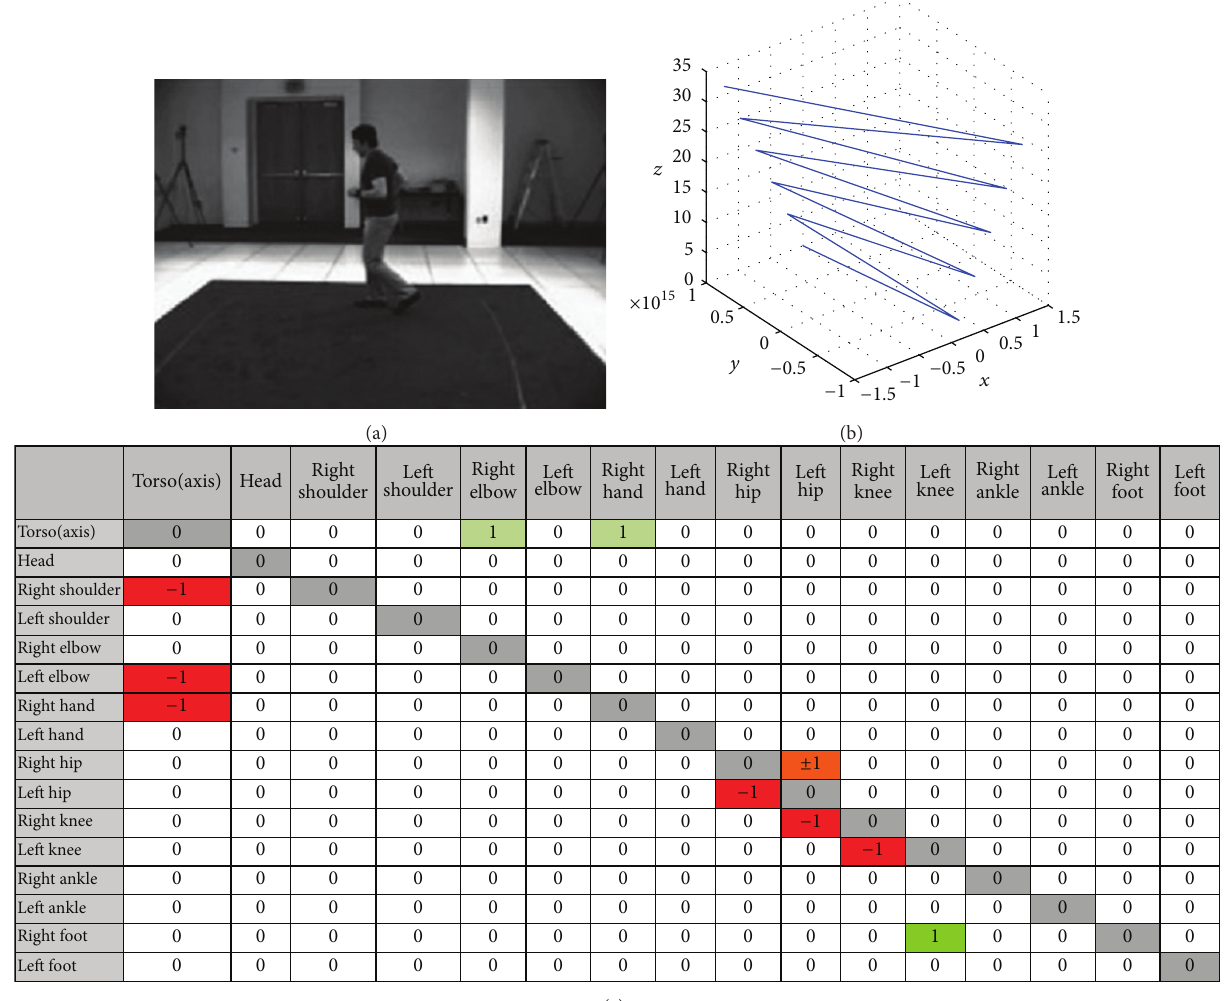
Figure 3: Process of restoring missing coordinate position Remarks: Figure 3 the original picture, Figure 3 Reconstruction of knee motion used the method of least squares data fitting in order to restore missing coordinate position, Figure 3 the occlusion diagram. In the diagram, occlusion part pairs, occlusion state value − 1 (red cell for occluded one) and 1 (green cell for occluder), ±1 (orange red cell for rigid body), respectively. In this manner, every part pairs get corresponding occlusion state